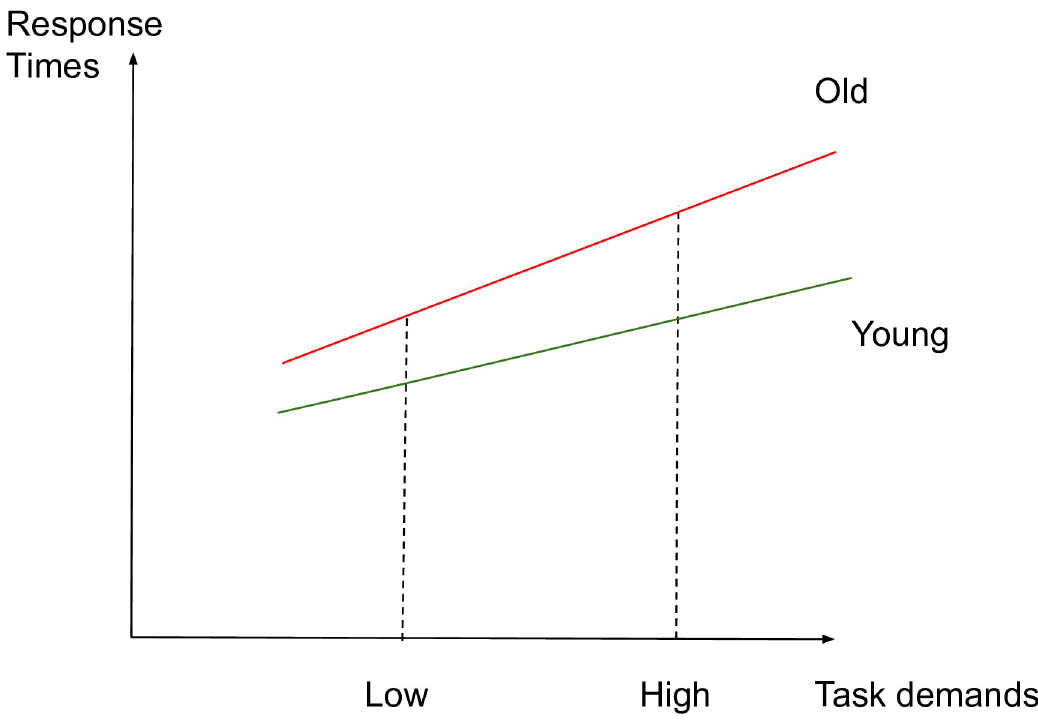
Fig 2. RTs and task demands in younger and older